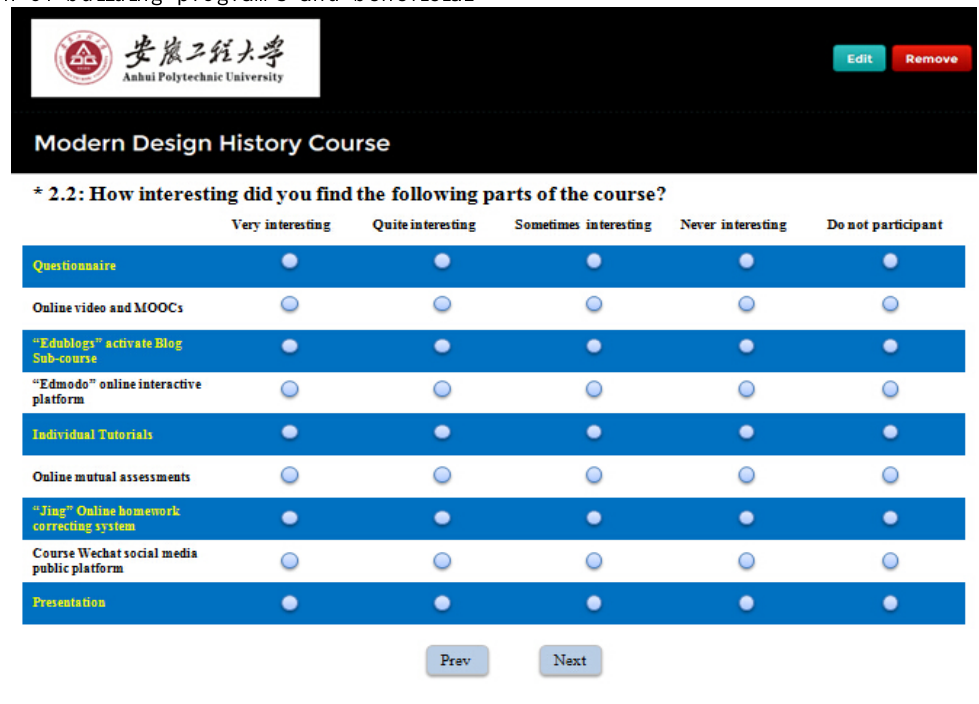
Figure 1. The Content Interface of